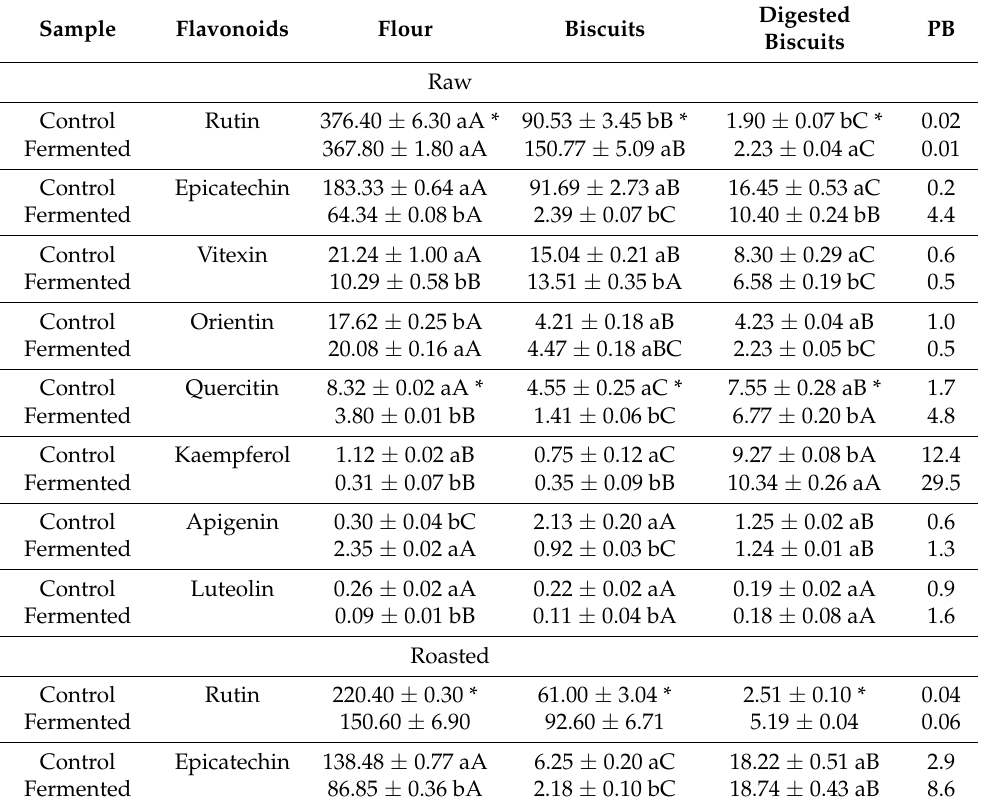
Table 3. The profile and total content of flavonoids ( µ g/g DM) and their potential bioaccessibility in raw and roasted buckwheat: flour, biscuits before and after in vitro